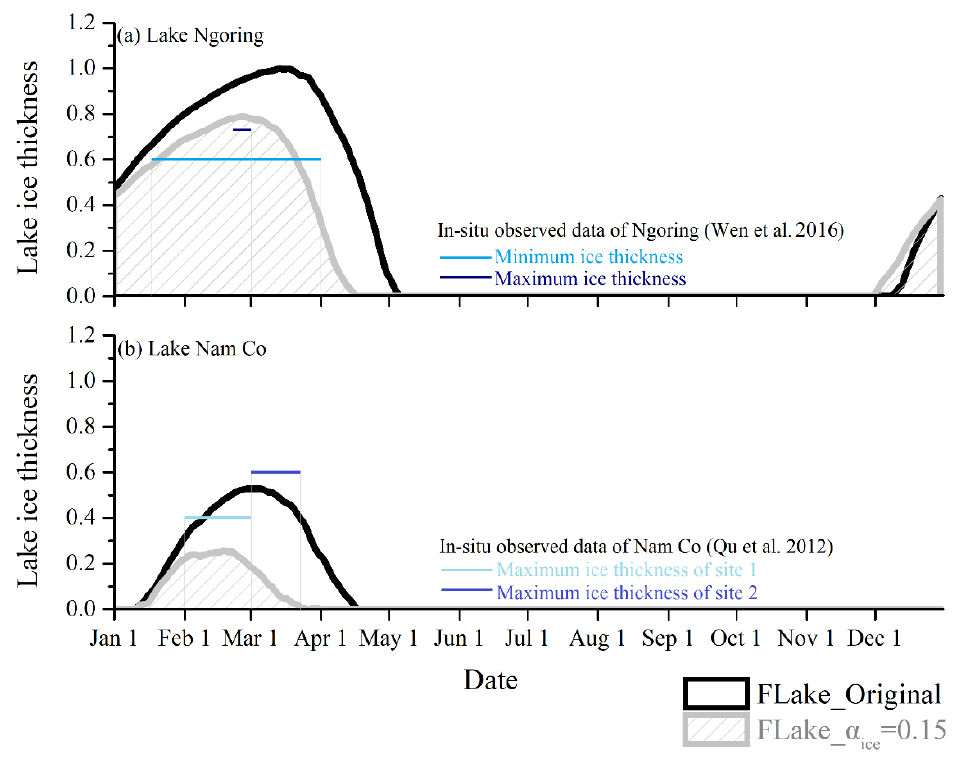
Figure 5. Seasonal variations in lake ice thickness from this study, from Qu et al. 2012 [83] (averaged over 2006–2011), and from Wen et al. 2016 [37] (averaged over December 2012 to March 2013) ( a ) for Lake Ngoring and ( b ) for Lake Nam Co.